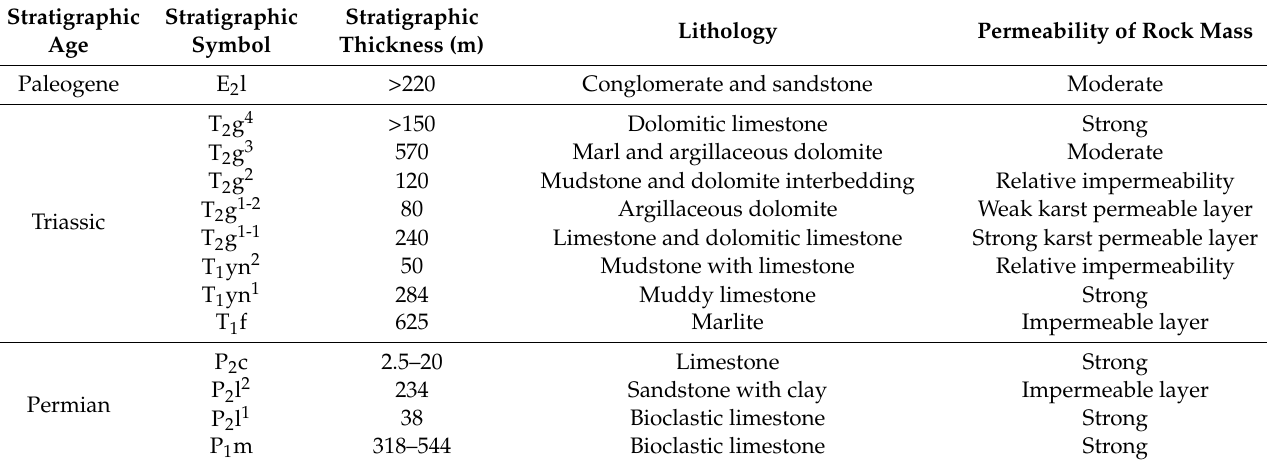
Table 3. Permeability statistics of different